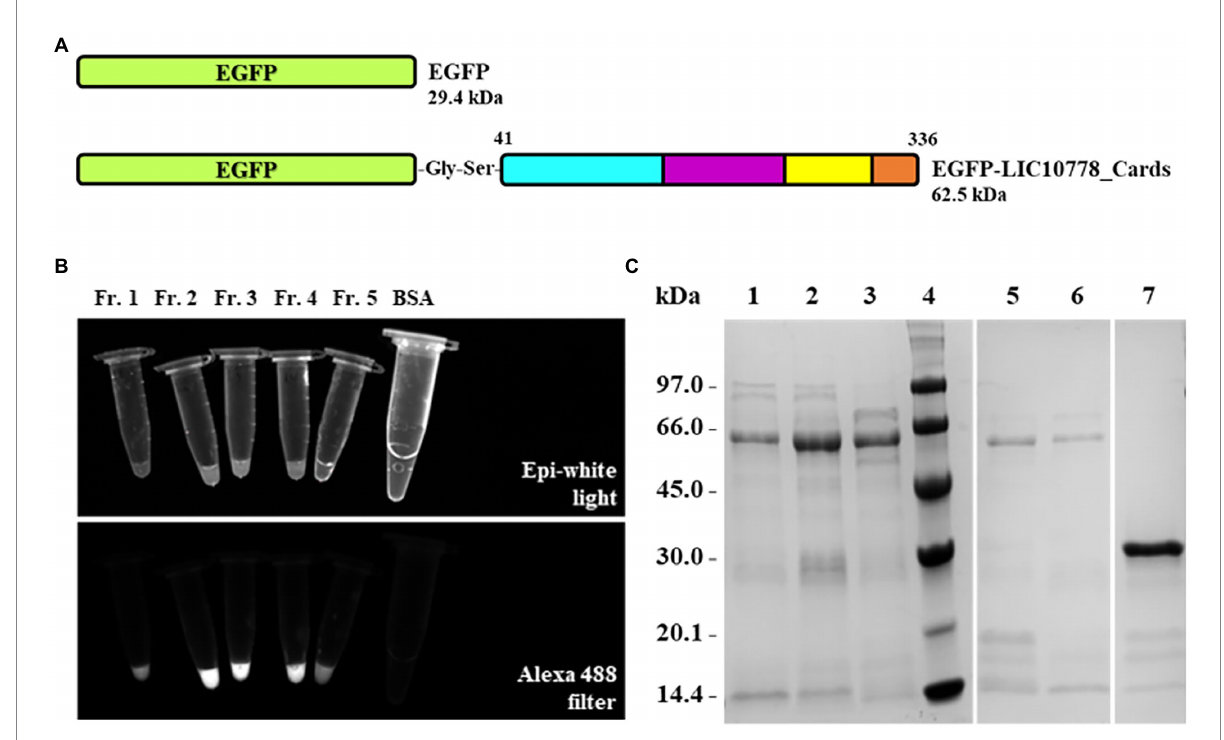
FIGURE 6 Expression and purification of EGFP-LIC10778_Cards protein. (A) Protein scheme of the recombinant proteins cloned into the pAZ expression vector corresponding to the sequences of the EGFP alone and the EGFP-LIC10778_Cards proteins. The portion of LIC10778 protein in this fusion has the same amino acid sequence as shown in Figure 4B. (B) Fluorescence evaluation of EGFP-LIC10778_Cards protein purified samples under exposure to Alexa 488 filter in ChemiDoc photodocumenter (Bio-Rad), in comparison to epi-white light exposure. Fractions 1 to 5 (Fr. 1–5) represent different elution fractions of protein purification on HisTrap column. A sample containing BSA was also evaluated as a negative control. (C) SDS-PAGE with the fractions of the recombinant proteins purified by IMAC. Samples of EGFP-LIC10778_Cards fused protein denominated as fractions 1 to 5 are represented in lanes 1, 2, 3, 5, and 6, respectively, recombinant EGFP were added in lane 7. Lane 4: molecular mass marker. SDS-PAGE with 12% polyacrylamide gel stained with Coomassie